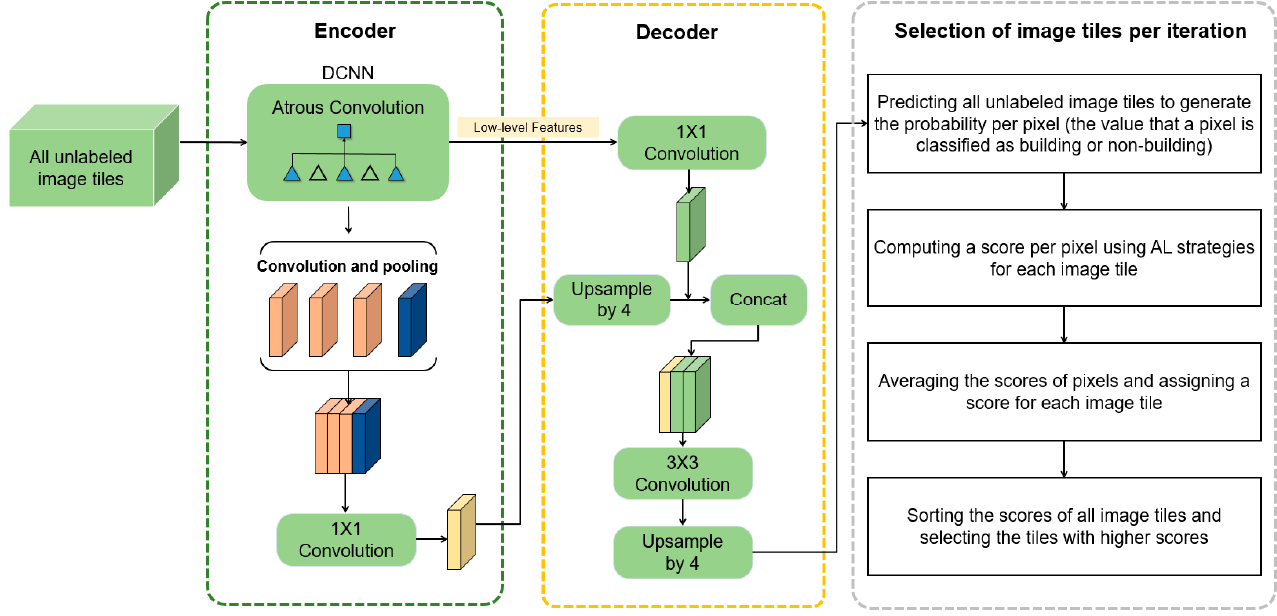
Figure 3. The process of active selection of unlabelled image tiles to be annotated in each iteration.